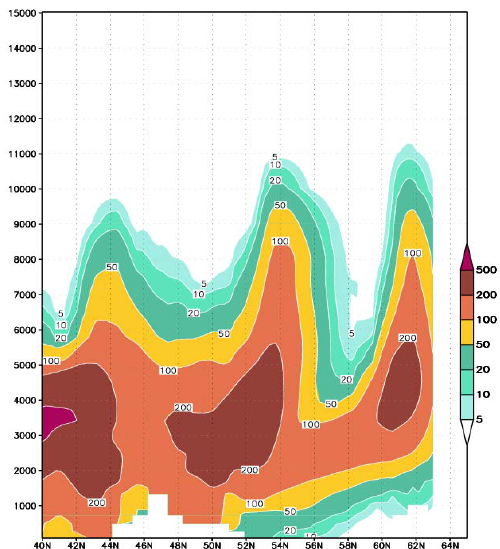
Fig. 4. North-south vertical transect of the mineral dust concentra- ) at 10 ◦ E on 29 May 2008 (12:00UTC) as modeled tion (PM model 10 by DREAM. The geographical position is marked by the red line in Fig. 3a.